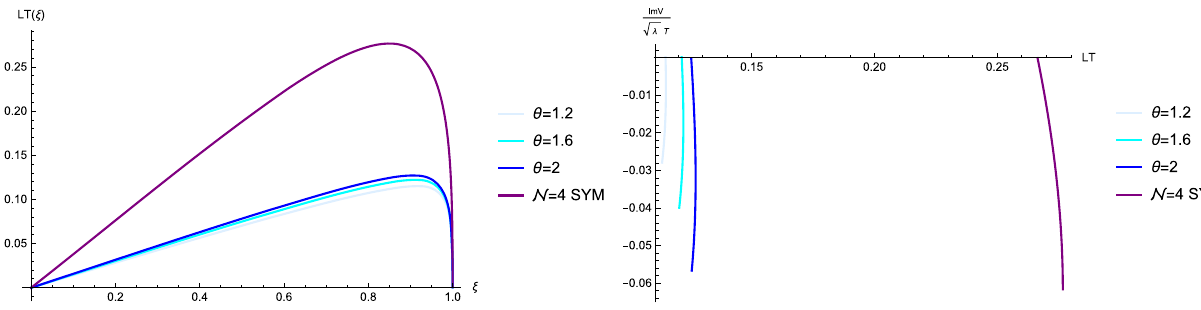
Fig. 2 Left: the plot of LT versus ξ in the different θ at z = 2 . 6 and μ/ T = 8. Right: ImV μ/ T = 8